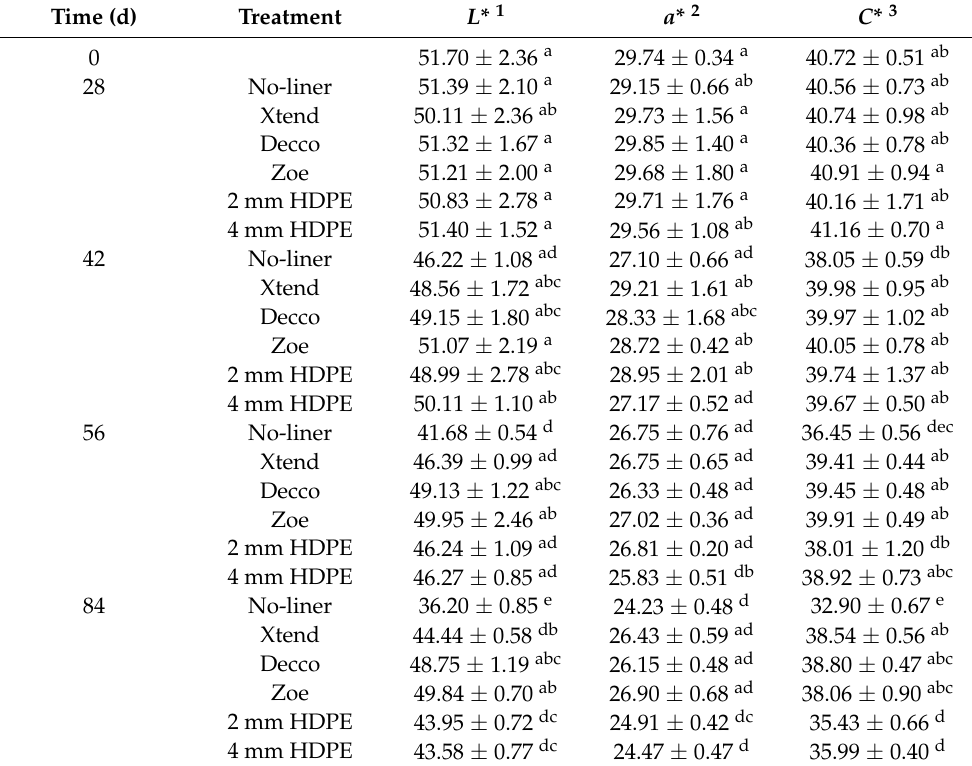
Table 5. Impact of liners on pomegranate fruit peel colour parameters. Fruit were stored at 5 ◦ C and 90% relative humidity